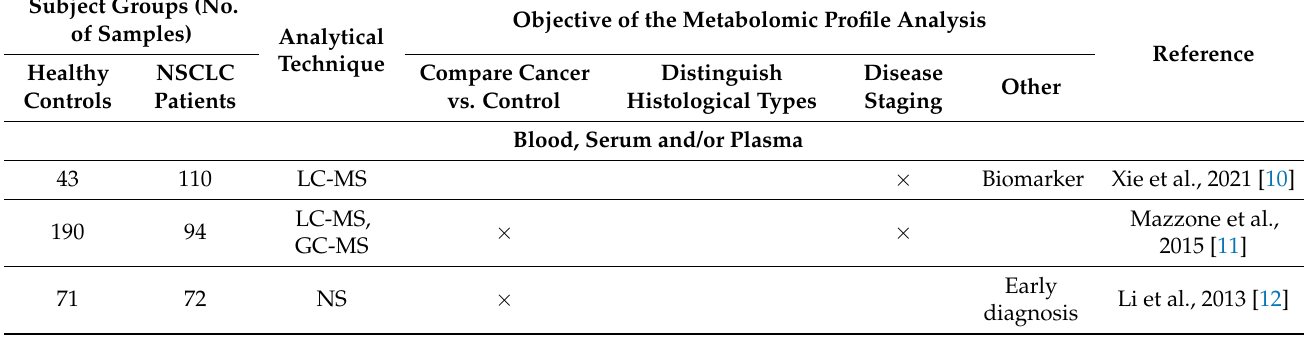
Table 2. Summary of the characteristics of the studies included in the